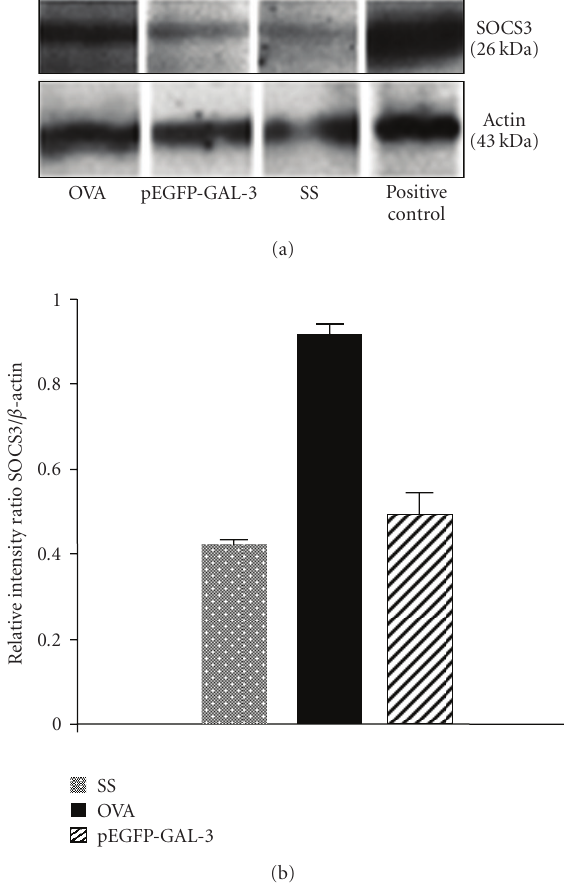
Figure 3: Western blot of SOCS3. (a) Protein extract from lungs was separated by 12% SDS-PAGE and blotted onto nitrocellulose membranes. Detection of SOCS3 was performed with goat anti- mouse IgG. Actin was used as the internal control. (b) SOCS3 bands were quantified by densitometry and corrected by actin expression. Densitometric analysis reveals a strong expression of SOCS3 protein in the OVA group, compared with the pEGFP-Gal-3 and SS groups. Data are expressed as the geometric mean ± SD, n = 4, ∗ P < .